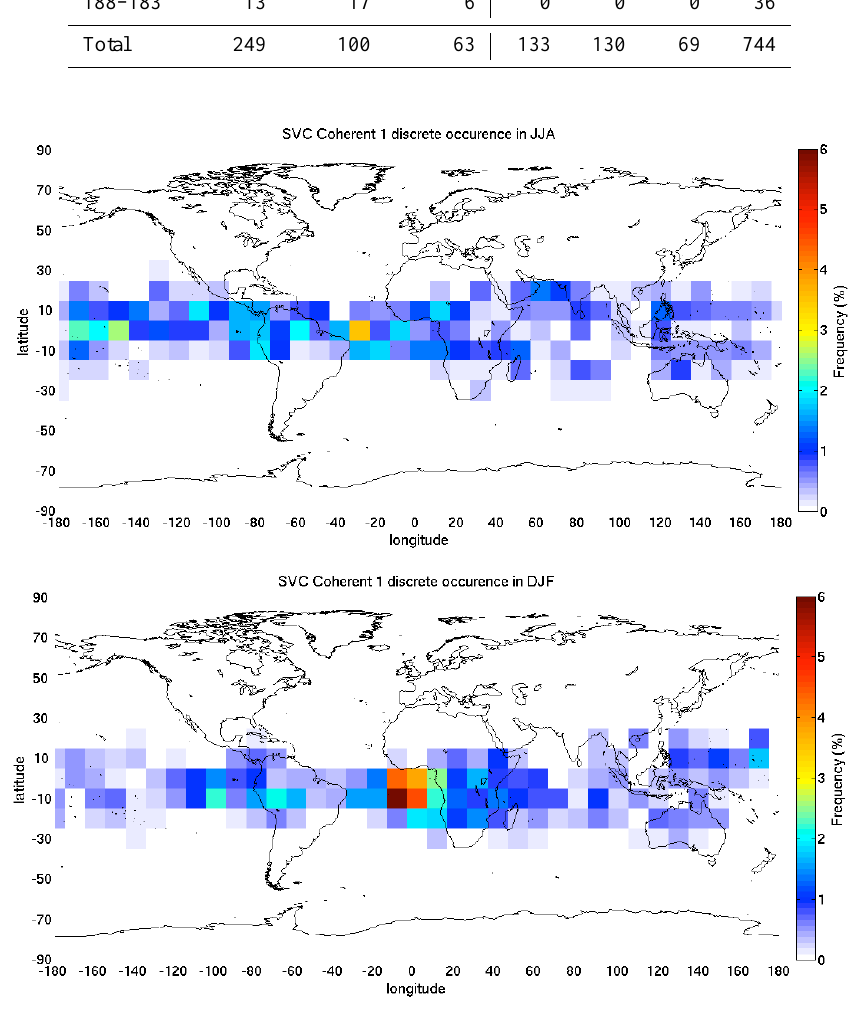
Fig. 7. Distribution of C1 SVC (% of total population) in JJA (top) and DJF (bottom).